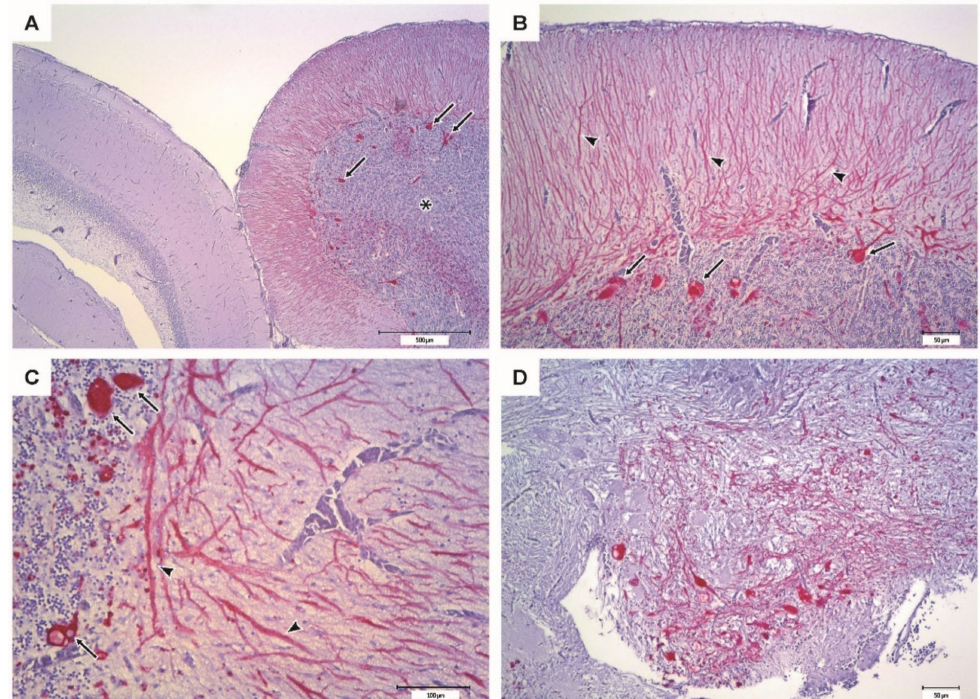
Figure 9. Immunohistochemistry of the encephalon from moribund sea bass (PBS, negative control group). Bright red coloring indicates the presence of RGNNV antigens. ( A – C ) Cerebellum (*) with intense immunostaining at different magnifications; the cortical of the optic lobes appears scarcely affected. Cerebellar Purkinje cell soma (arrows) appears strongly IHC positive, while their dendritic process (arrowheads) is also highlighted in the molecular layer. ( D ) Diencephalon showing intense immunostaining.